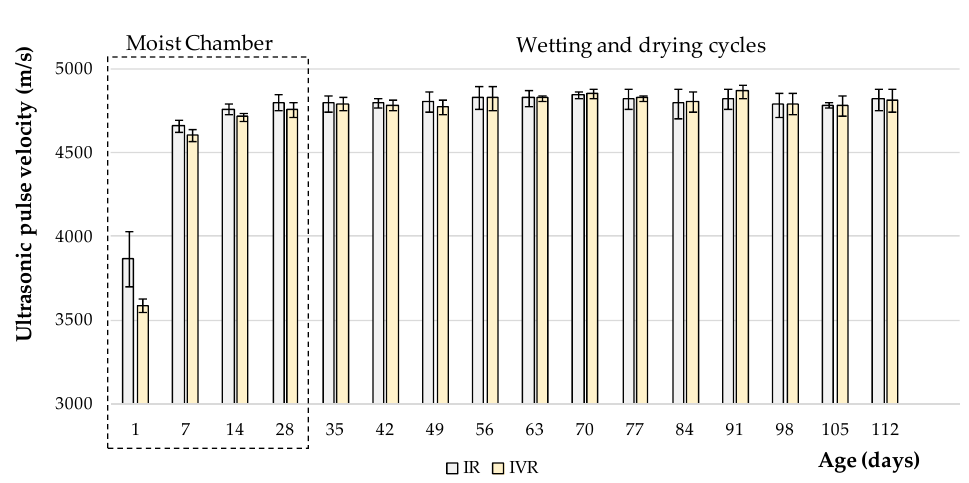
Figure 1. Ultrasonic pulse velocity of the uncracked concrete with CEM I and CEM